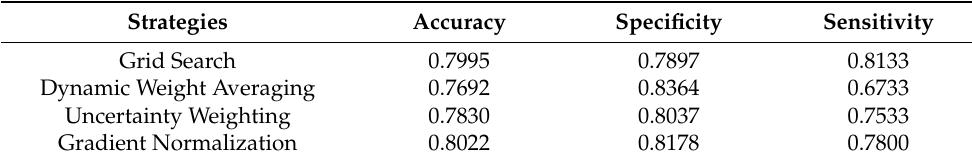
Table 1. Comparative experiments on different loss optimization strategies.